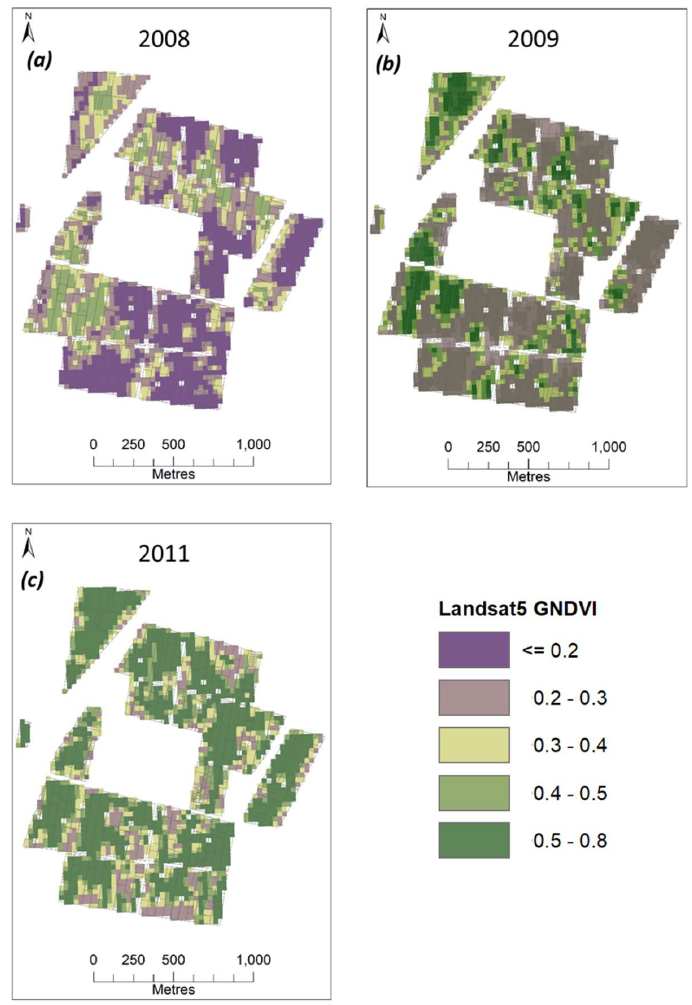
Figure 3. Calculated Green Normalized Vegetation Index (GNDVI) for LANDSAT 5 scenes for the growing season ( a ) 2008; ( b ) 2009; and ( c ) 2011. LANDSAT 5 scenes were obtained for late April/early May every year from 2008 to 2011.